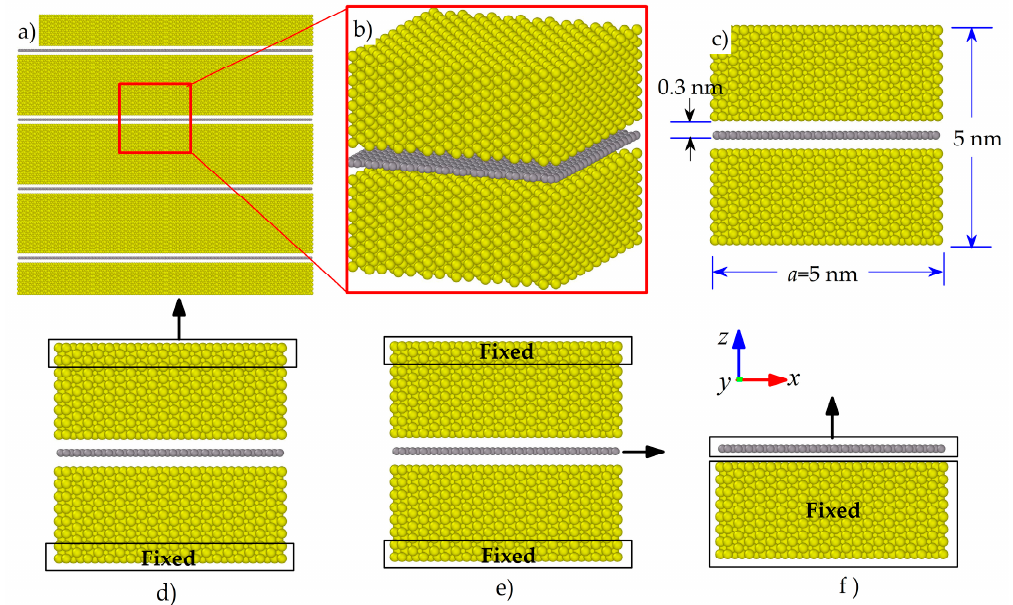
Figure 1. Schematic models of the GANC: ( a ) an overall model; ( b ) a RVE model; ( c ) the dimension of the RVE model; ( d ) pull-up simulation; ( e ) pull-out simulation; ( f ) cohesive law simulation.